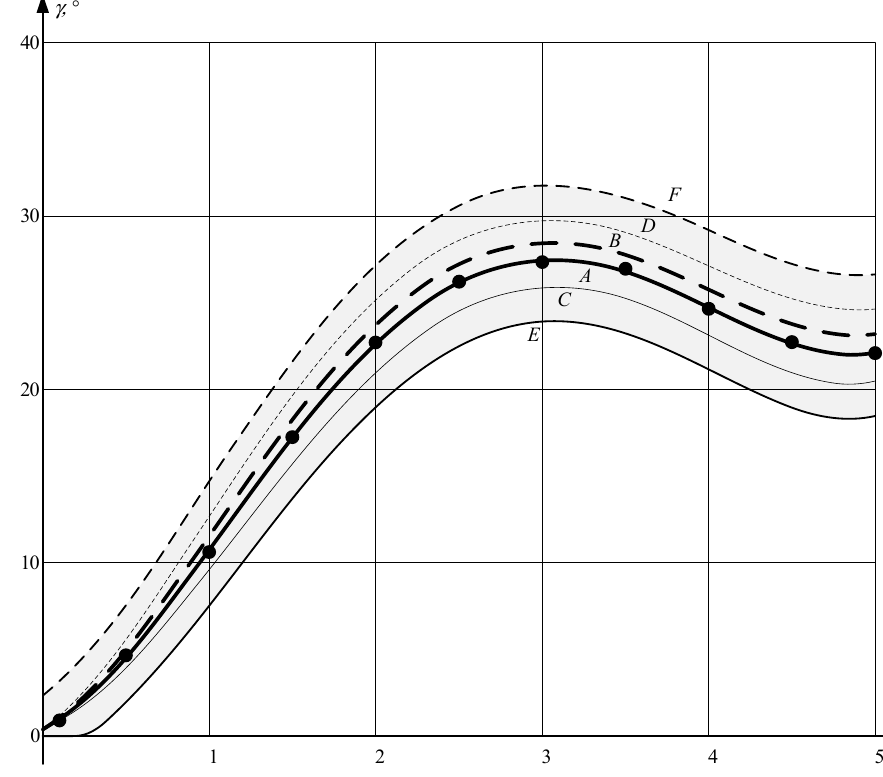
Figure 10. MTPA constraints design in i d i q plane.